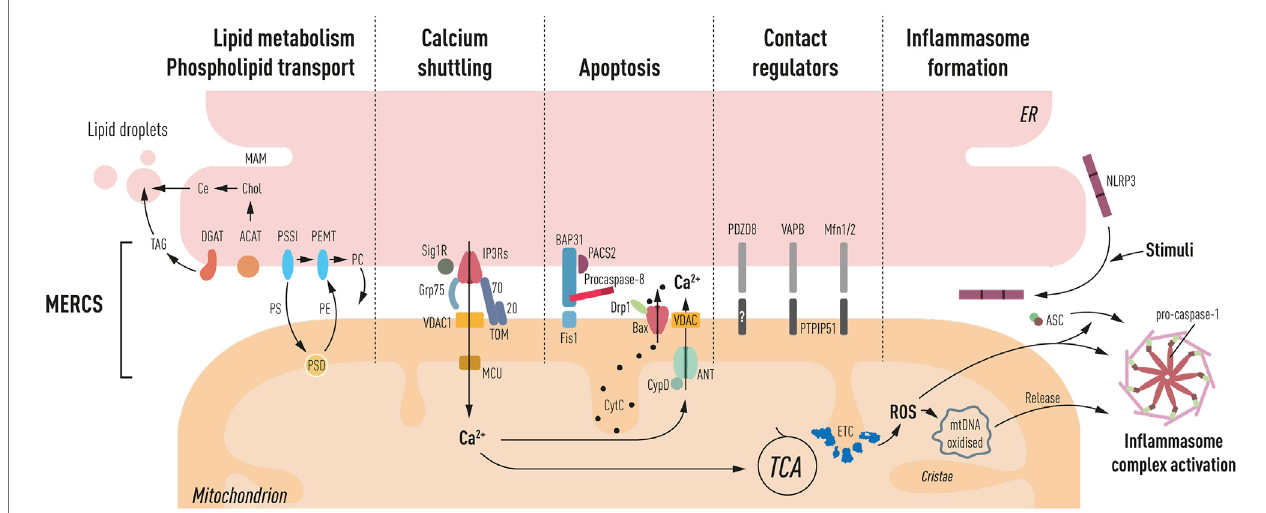
FIGURE 1 | Schematic representation of processes ascribed at MERCS: lipid metabolism and phospholipid transport . PS, phosphatidylserine; PE, phosphatidylethanolamine; PC, phosphatidylcholine; shuttling occurs through MAM, OMM, and IMM triple contact sites, and PSSI, PSD, and PEMT mediate their synthesis, respectively.Furthermore, the synthesis of cholesteryl esters (Ce) through ACAT and triglycerides (TAG) through DGAT occurs at the MAM, which isthe main component of lipid droplets, generated close to the ER and mitochondria interface. Ca 2+ shuttling between the ER and mitochondria is mediated by IP3Rs. Grp75 mediating close juxtaposition of IP3Rs to VDAC in the OMM and MCU in IMM facilitates Ca 2+ entry into the matrix leading to TCA cycle activation. Sig1R and TOM70 mediate the IP3R activity. Apoptosis PACS-2, a multifunctional sorting protein, by localizing to the MAM regulates BAP31 interaction with Fis1, mediating a platform for procaspase-8 activation. Increased Ca 2+ in the matrix can lead to activation of mPTP (CyD, ANT, and VDAC). Bax has also been located at MERCS, and upon apoptosis induction, it leads to the formation of pores and cytochrome c (CytC) release. Contact regulators ’ several proteins have been shown to have a role in mediating ER to mitochondria apposition including PDZD8, VAPB – PTPIP51, and Mfn2, a negative regulator of MERCS. In fl ammasome formation NLRP3 under resting conditions is located in the ER membrane, upon in fl ammatory stimuli recruits ASC and redistributes at the MAM. Mitochondrial ROS production and oxidized DNA release induce the activation of the autophagosome complex, consisting of NLRP3, ASC, and pro-caspase-1 propagating the in fl ammatory response.